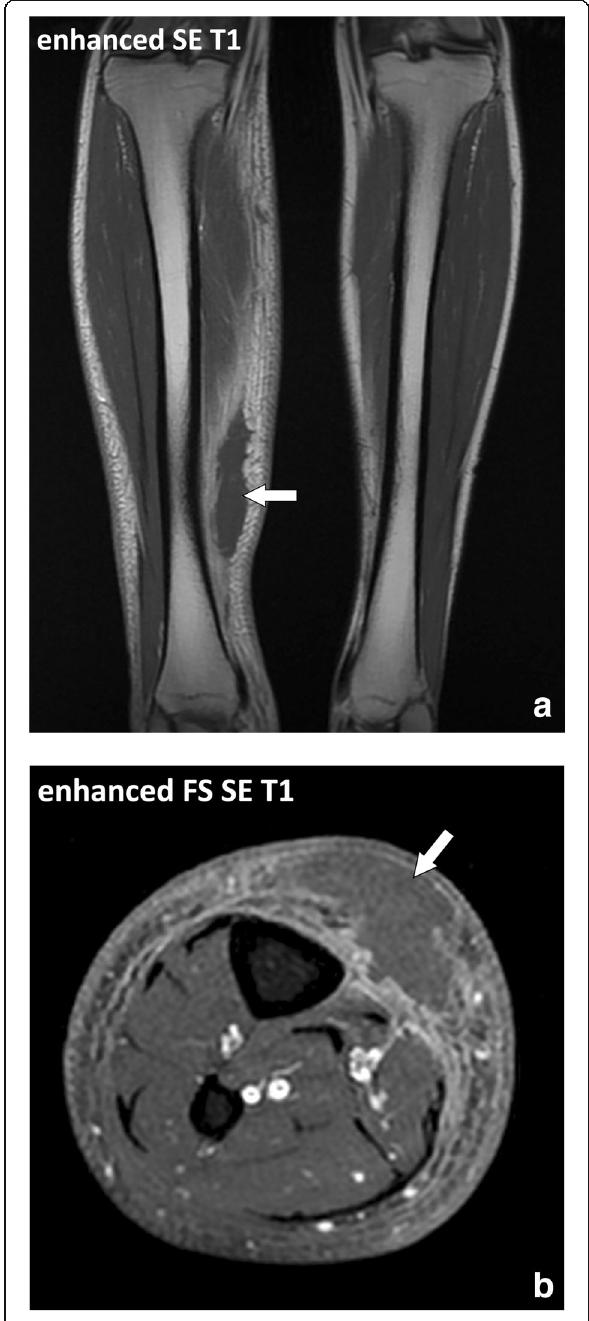
Fig. 8 a Coronal contrast-enhanced and ( b ) axial contrast-enhanced fat-suppressed SE T1w images of the legs of a 25-year-old immunosuppressed male with rheumatoid arthritis and cellulitis of the left leg. Inflammatory infiltration of the fascia superficialis is centered around a large hypodermic fluid collection with irregular margins